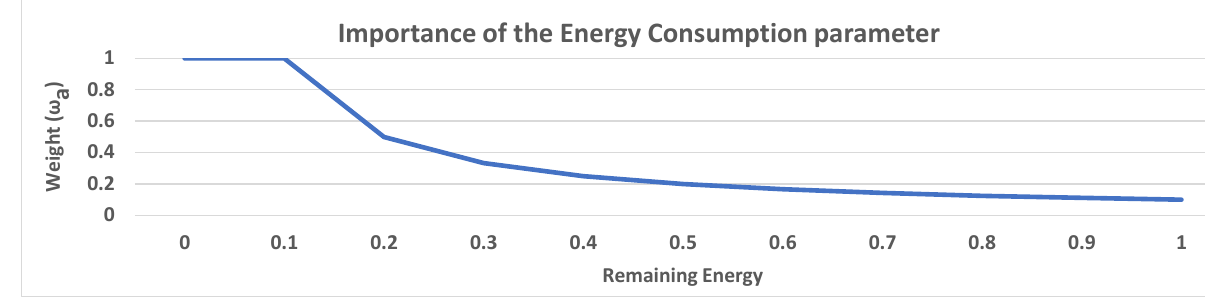
Figure 18. Network selection weights for SLA3.